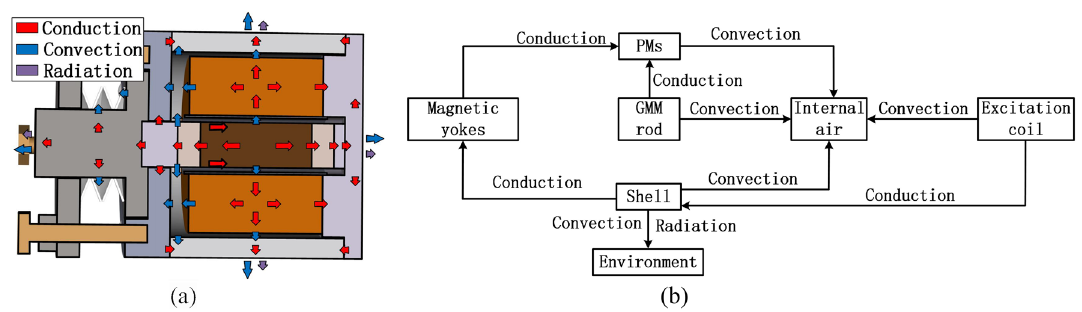
Figure 2. Heat transfer process in the longitudinal vibration GMT: ( a ) Heat flow diagram, ( b ) Main paths for heat